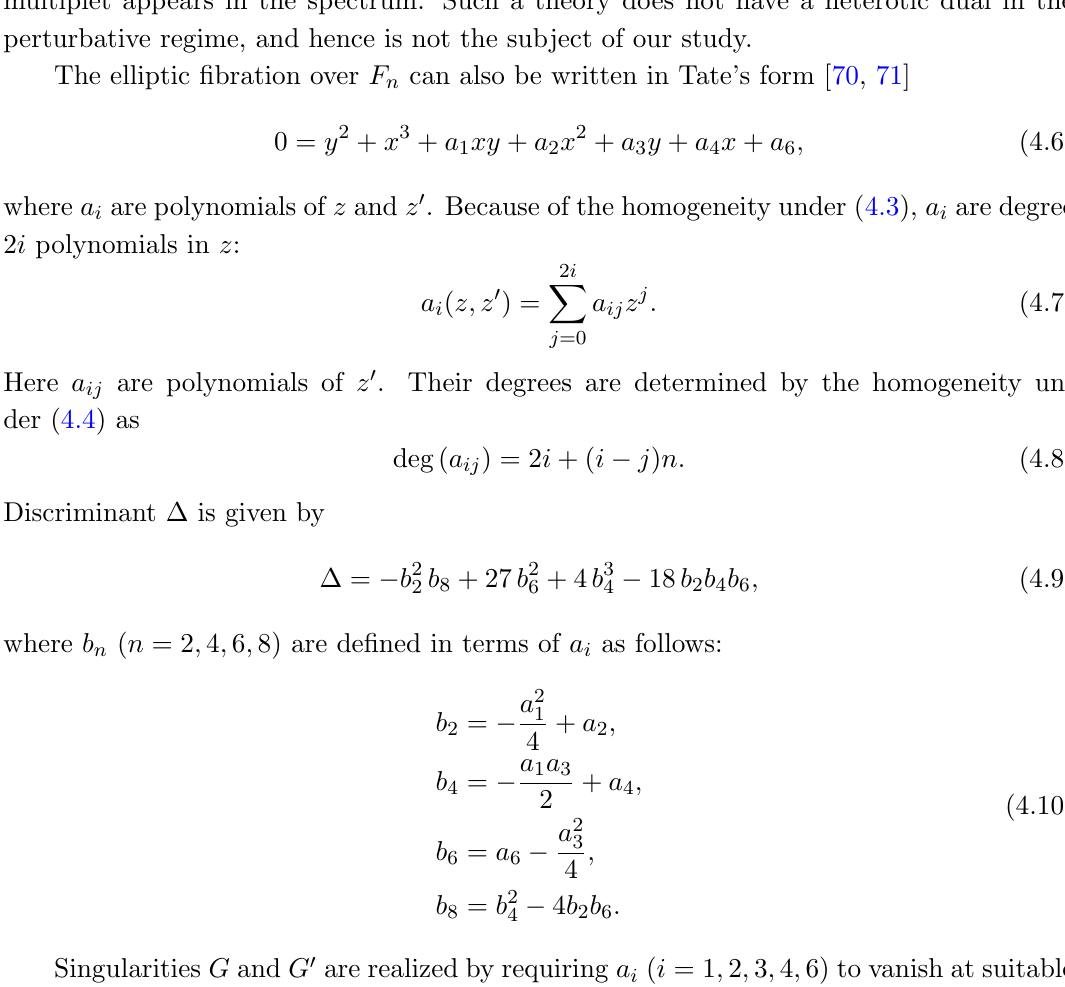
table 8 the (cid:12)bers for which the split condition is satis(cid:12)ed (the subscript \s" is attatched 7 ). The (cid:12)rst six columns of the table represent the lowest orders of a column is the coe(cid:14)cient of z ord((cid:1)) , where b